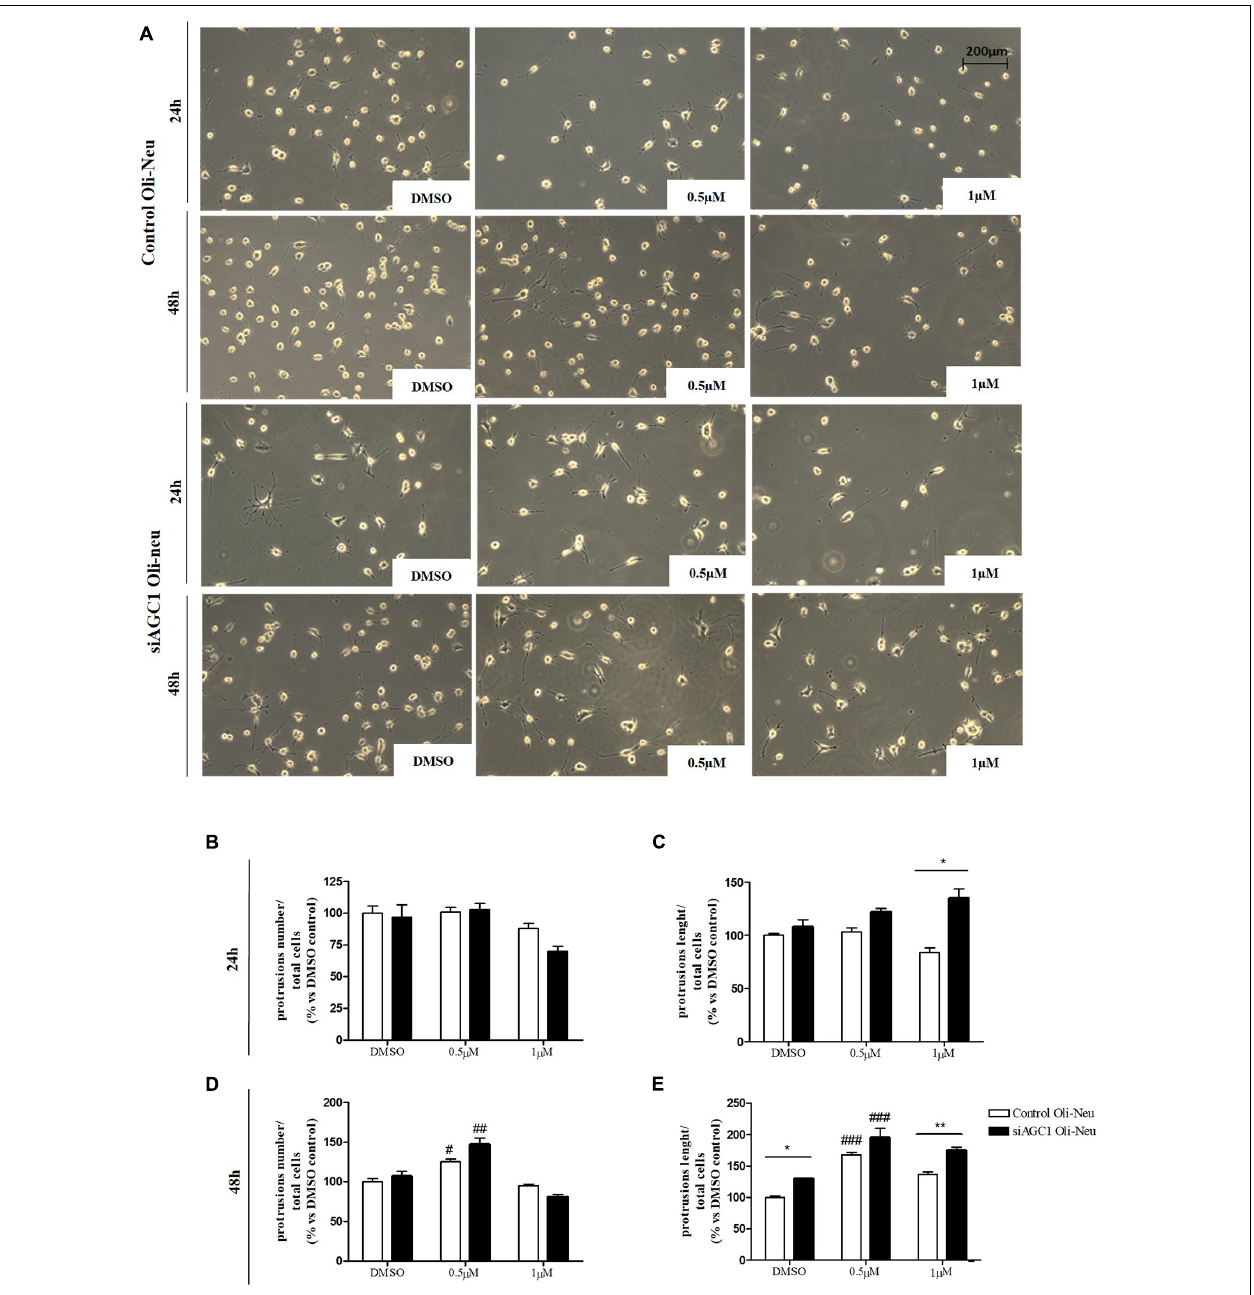
FIGURE 10 | Histone deacetylases inhibition leads to Oli-Neu cells differentiation with a decrease in filament number and increases in filaments length in siAGC1 cells compared to control ones after 48 h SAHA treatment. Optical microscope proliferation/differentiation analysis in siAGC1 and control Oli-Neu cells following 24 and 48 h of SAHA treatment (A) . The number and lengths of filaments were counted and measured, respectively, and analyses were carried out with Fuji Imagej2 software (B–E) . Analysis was carried out with Fuji Imagej2 software. Values are mean ± SD of 3 independent experiments; 3 different fields were acquired for each condition. 20X objective; 200 µ M bar scale. # p < 0.05, ## p < 0.01, ### p < 0.001, compared to DMSO control, respectively; * p < 0.05, ** p < 0.01, compared to each treated control; two-way ANOVA (Bonferroni’s post hoc